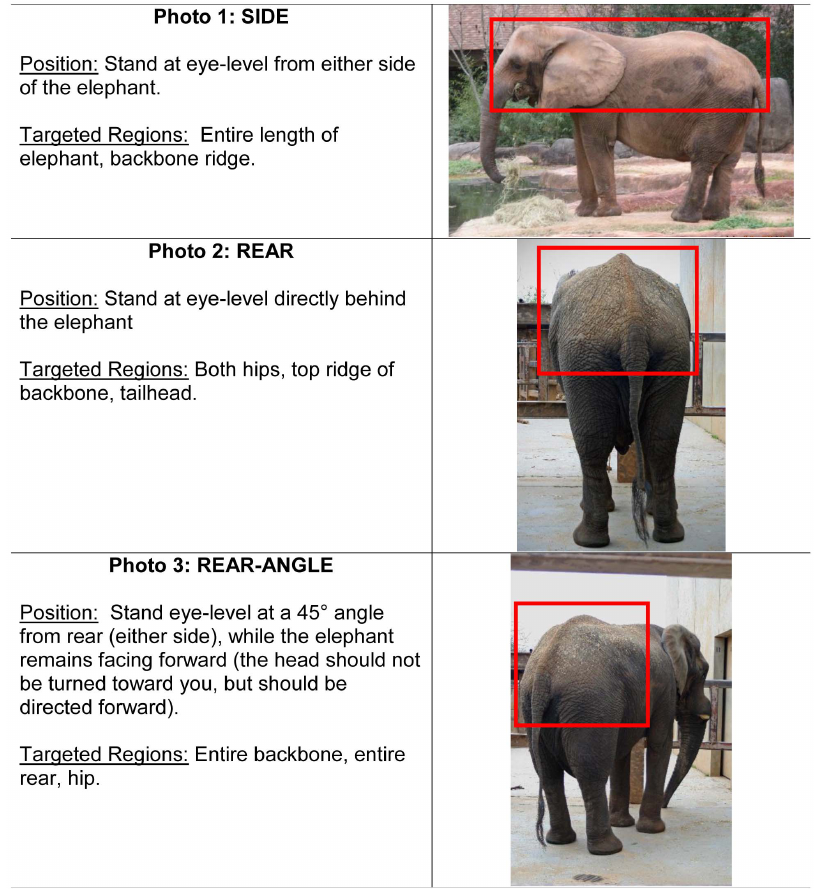
Figure 1. Guide for taking standardized photographs for body condition scoring.